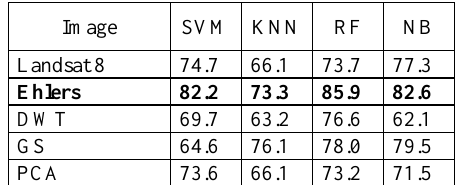
Table 8. Overall accuracies of the classification results in %. Best accuracy is achieved by the Random Forest classification of the Ehlers Fusion image.